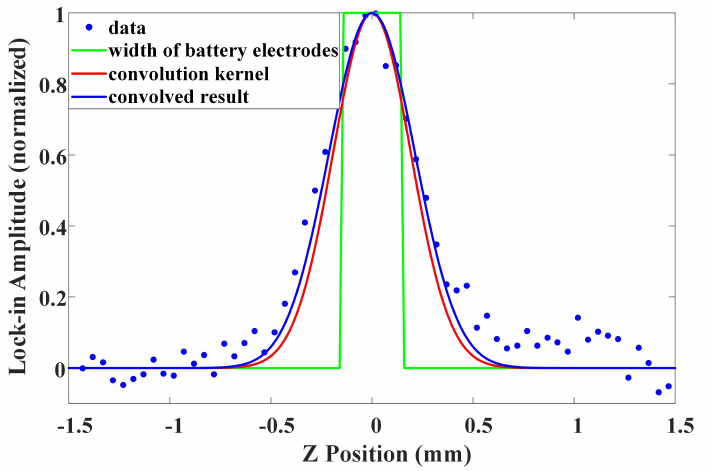
Figure 7. Determination of spatial resolution. The blues dots signify the average cross section of the 0.3 mm-width electrode imaged by the sensor, the green trace denotes the width of electrode of battery as a square function, and the red curve represents a Gaussian function, as a convolution kernel of the green trace to fit the experimental data, noted as a blue